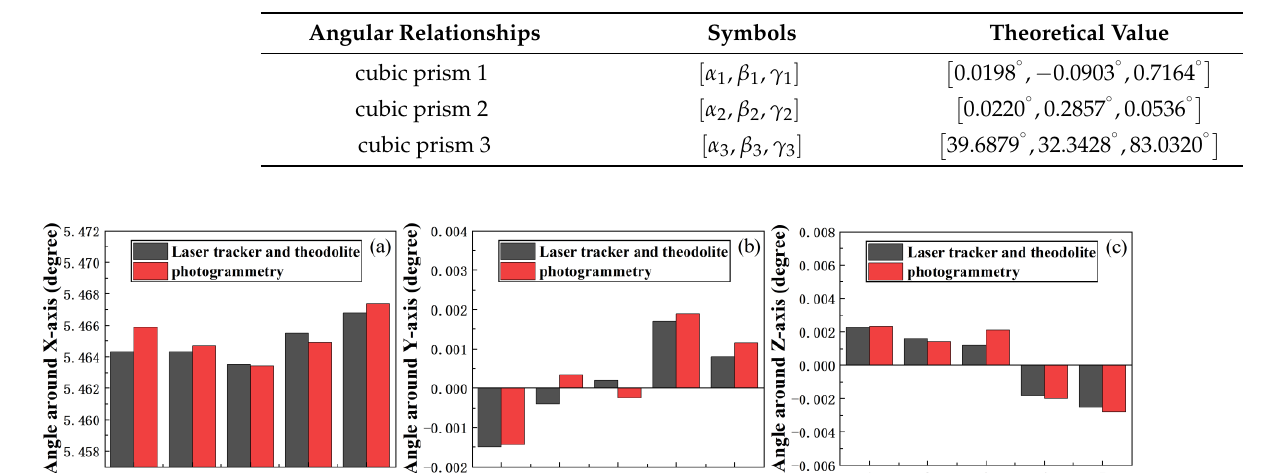
Table 5. Cubic prism mounting angle.